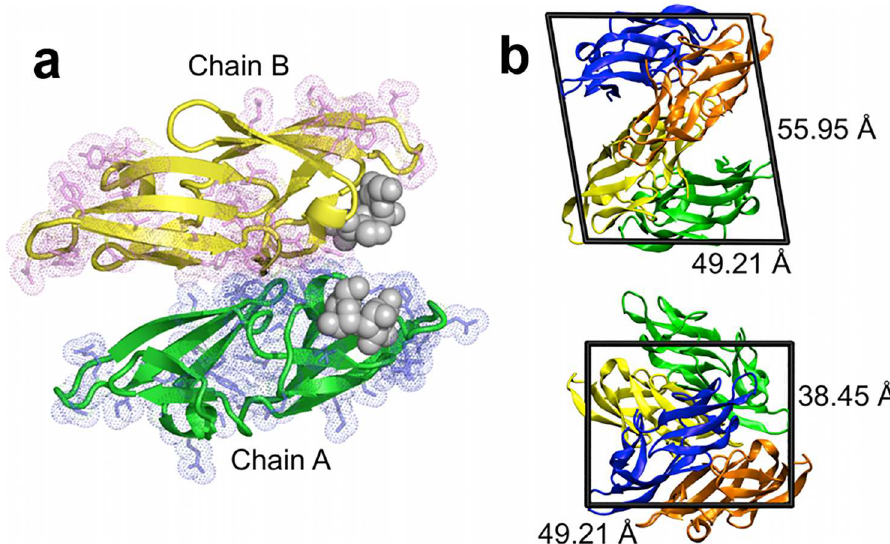
Fig 1. Crystal environment of CVN. (a) The two crystallographicallyindependentmolecules(A and B) of the P51G-m4-CVN complex(PDB ID: 2RDK) [17]. The secondary structure of moleculesA and B are shown in green and yellow cartoon representation, and the di-mannoseligandsare depicted as grey spheres. Residues participating in crystal contacts with neighboring moleculesare shown as sticks and dots, colored in blue and magentafor moleculesA and B, respectively. (b) The simulatedtriclinic CVN unit cell comprises four chains: two chain A’s (blue and green) and two chain B’s (orangeand yellow). One A/B pair (e.g., the green and yellow chains)forms the asymmetric unit in the originalmonoclinic crystal